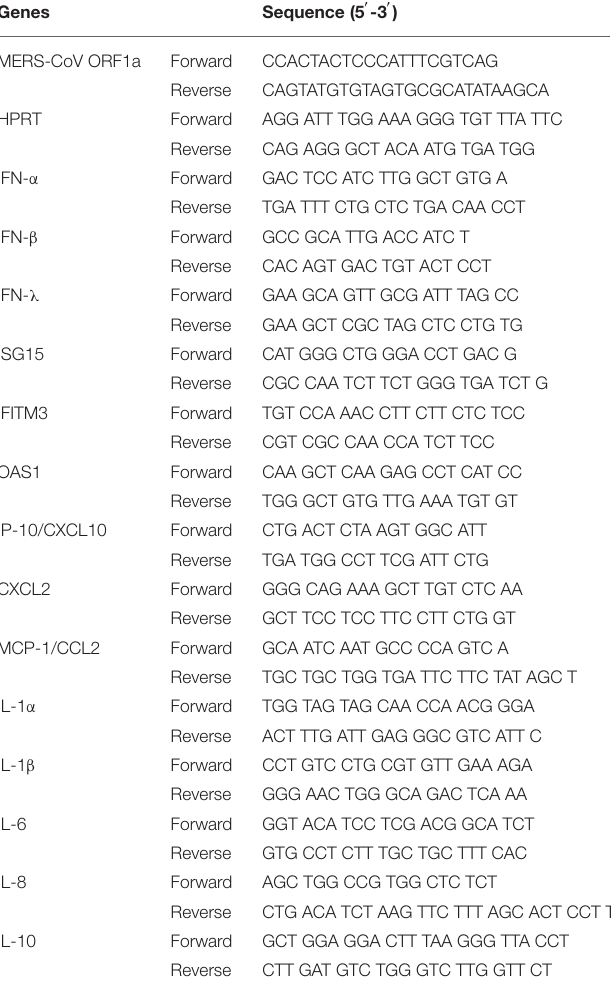
TABLE 1 | Primer Sets for